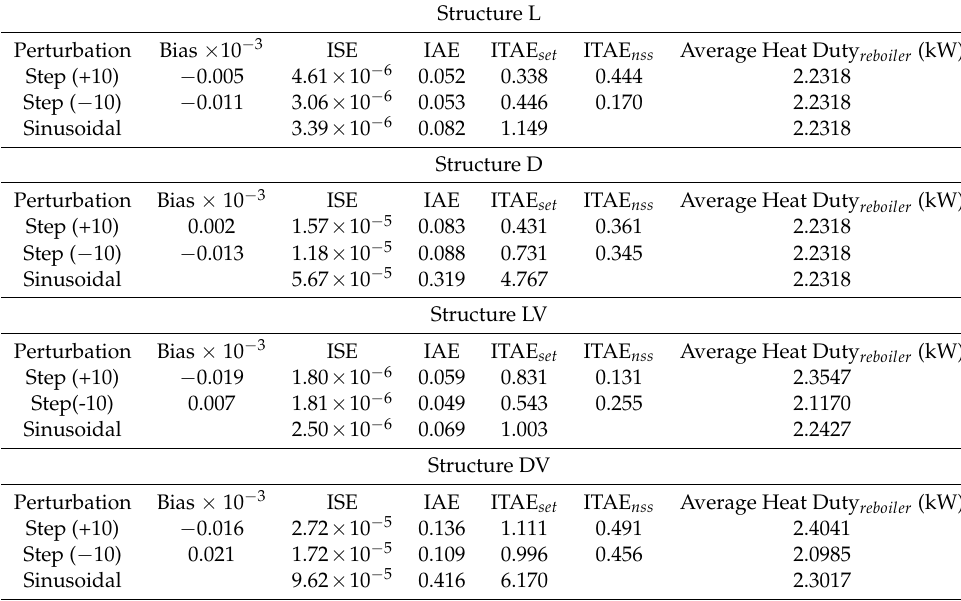
Table 13. Summary of the error indices of the control structures before the disturbances in the feed flux main rate.